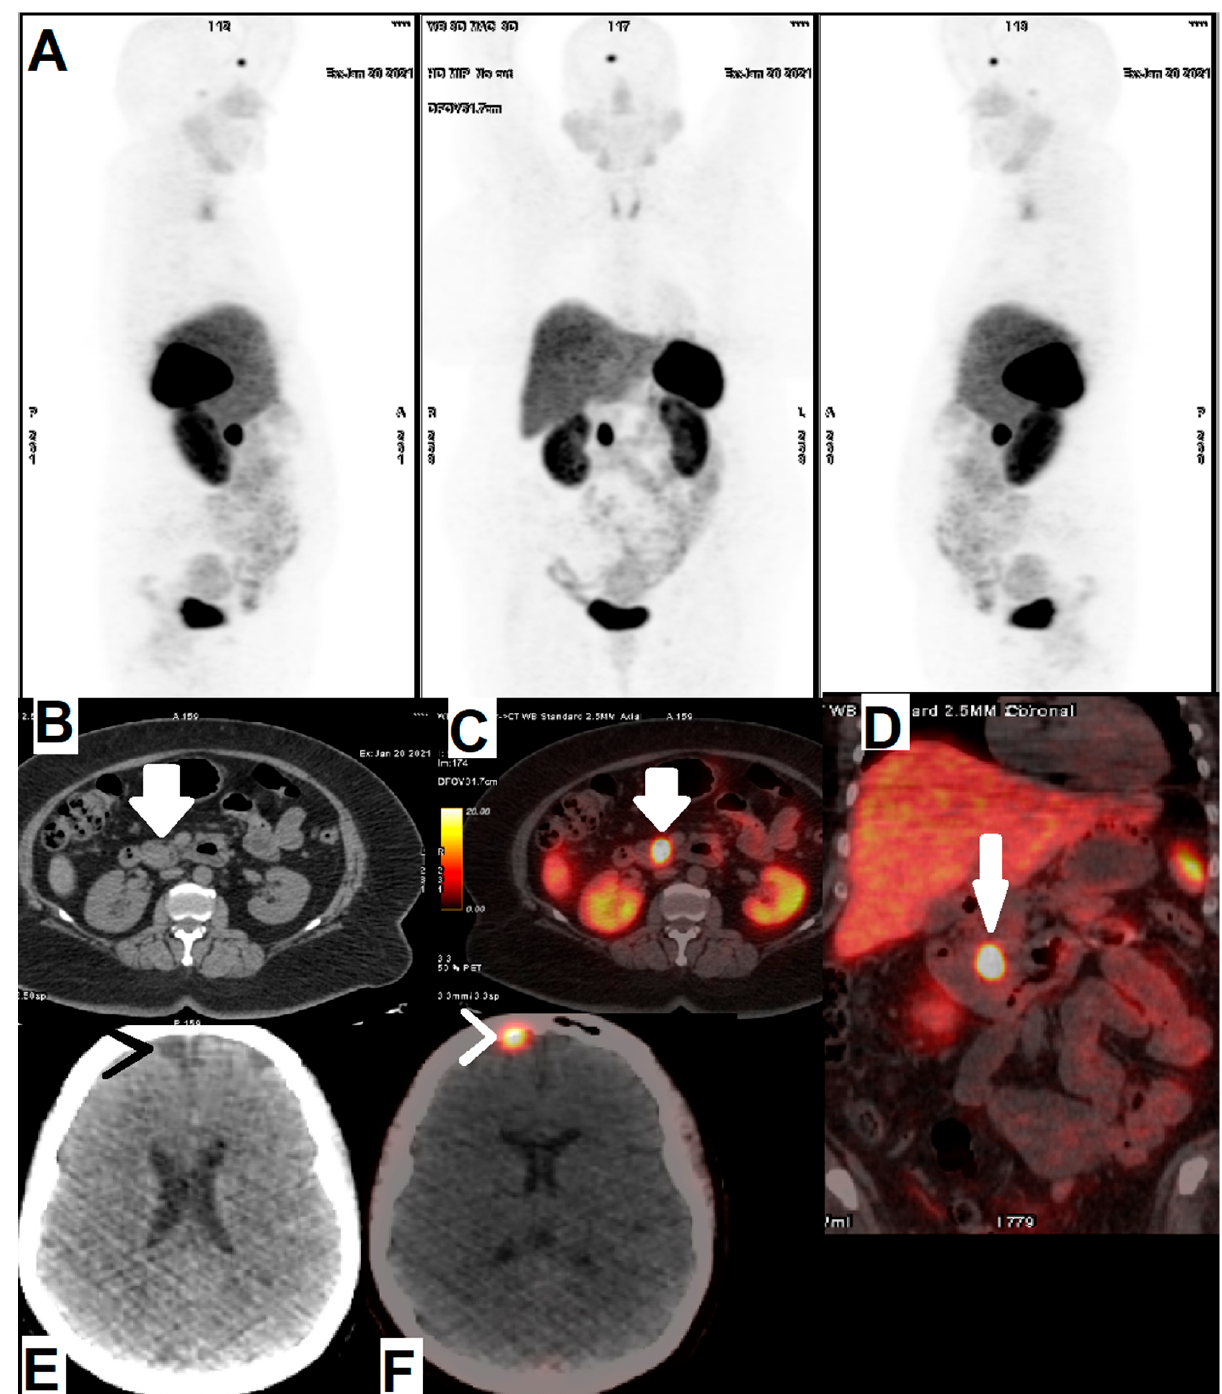
Figure 2. A 58-year-old man with a history of intractable peptic ulcers and hypergastrinemia referred for [ 68 Ga]Ga-DOTA-TATE PET/CT scan. ( A ) MIP images in right lateral, anterior and left lateral views. Axial CT scan ( B ) and fused axial ( C ) and fused coronal ( D ) PET/CT showed a somatostatin receptor avid lesion in the pancreatic head (arrows), suggesting a NET (gastrinoma). An interesting incidental finding of a hypodense brain lesion in the right frontal lobe paramidline adjacent to falx cerebri at CT scan ( E ) showed [ 68 Ga]Ga-DOTA-TATE avidity (arrow heads) on fused PET/CT ( F ) images in favor of a meningioma.